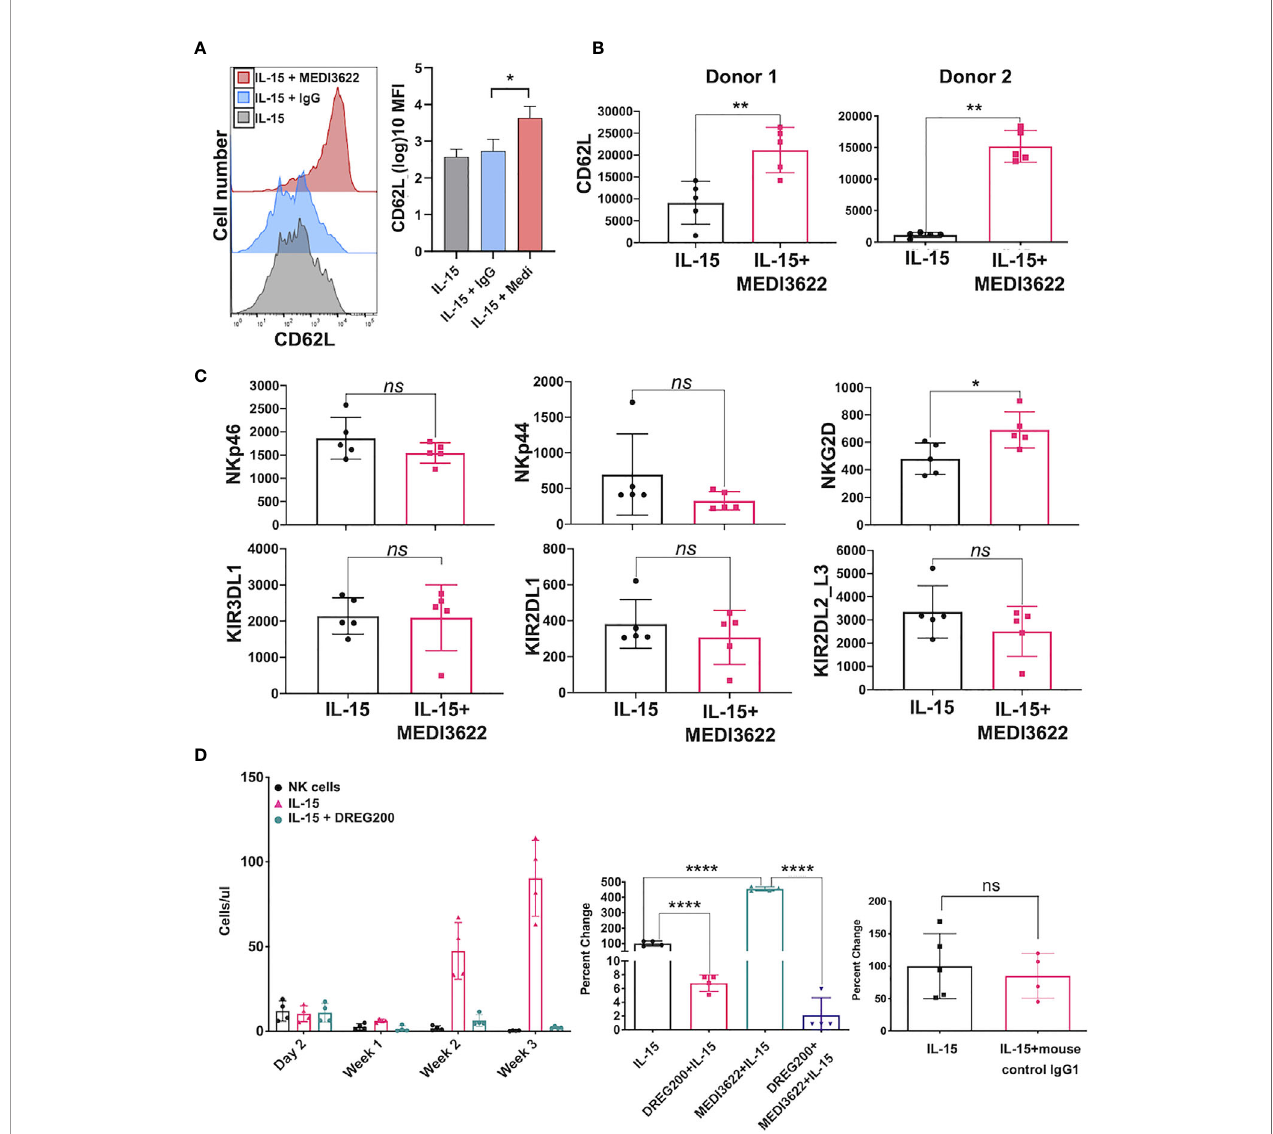
FIGURE 3 | CD62L expression during NK cell proliferation and its role in their expansion in vivo . (A) NK cells were placed in culture for 7 days in the presence of rhIL-15 (10ng/ml) alone or in the presence of MEDI3622 (5 m g/ml) or an isotype-matched negative control mAb (IgG, 5 m g/ml). CD62L levels were determined by fl ow cytometry. The histograms show representative data and the bar graph shows mean ± SD of 3 independent experiments using leukocytes from separate donors. *p < 0.05. The y- axis on the bar graph indicates mean fl uorescence intensity (MFI). Statistics were calculated as described in Figure 1 . (B) Mice were administered enriched NK cells and rhIL-15 (5 m g) in the presence or absence of MEDI3622 (10 mg/kg). After 3 weeks, mouse peripheral blood was collected, and relative CD62L expression levels were determined on human CD45 + CD56 + CD3 − NK cells by fl ow cytometry. Two separate experiments are shown using NK cells from different donors. The y-axis on the bar graphs indicates MFI. Data are mean ± SD (n = 5 mice per group). **p < 0.01. (C) The experiment was performed as described in panel B and various cell surface markers were evaluated. Data are representative of two separate experiments using NK cells from different donors. Data are means ± SD (n = 5 mice per group). *p < 0.05; ns = not signi fi cant. Data was analyzed by using unpaired two-tailed student ’ s t-test. (D) Mice were administered NK cells and rhIL-15 (5 m g) in the presence or absence of DREG200 (10mg/kg) (left panel), DREG200 and/or MEDI3622 (10mg/kg) (middle panel), or mouse IgG isotype-matched mAb (10mg/kg) as a control for DREG200 (right panel). The number of NK cells in the peripheral blood were enumerated by fl ow cytometry and are shown as cells/ m l or as percent change normalized to NK cells plus rhIL-15. Data are means ± SD (n = 4 to 5 per group). ****p < 0.0001; ns, not signi fi cant. Data was analyzed by using unpaired two-tailed student ’ s